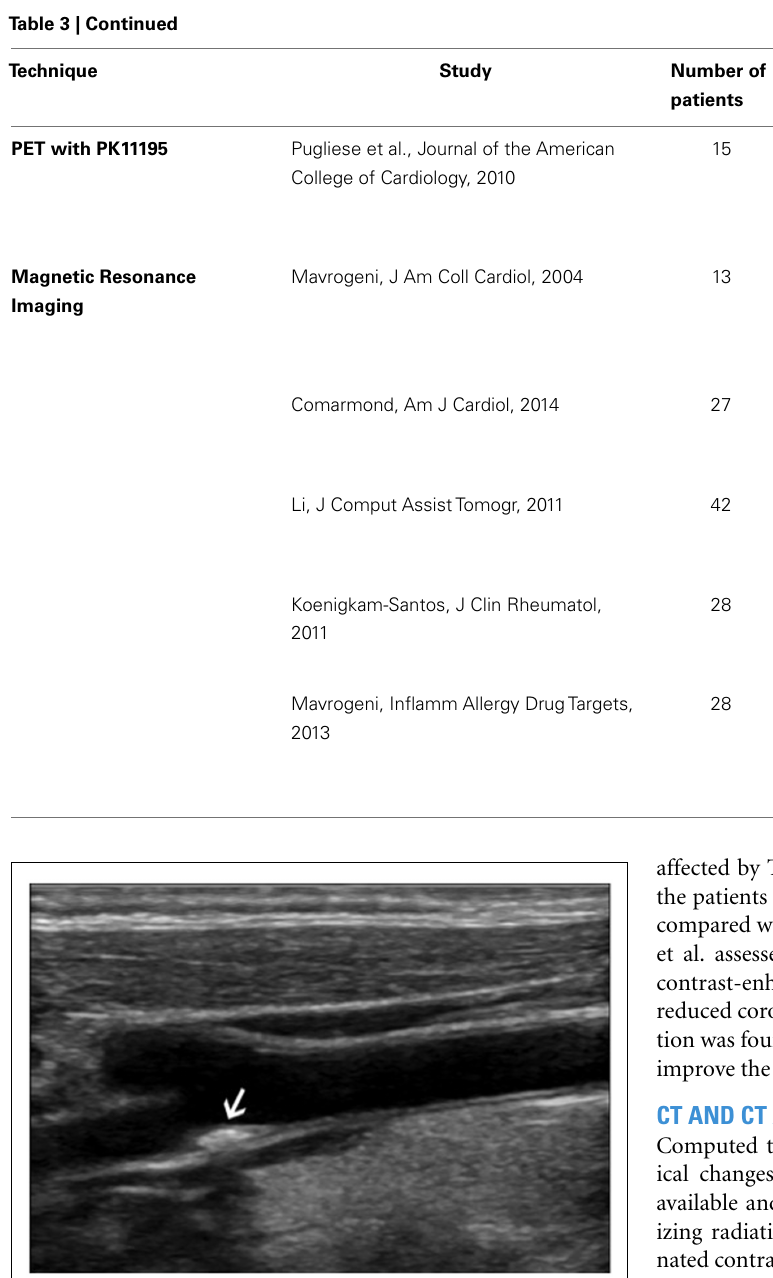
FIGURE 1 | Ultrasound imaging of the right carotid artery bifurcation of a 44-year-old woman with a 10years history of systemic lupus erythematosus: the arrows show an atherosclerotic plaque extending toward the internal carotid artery .